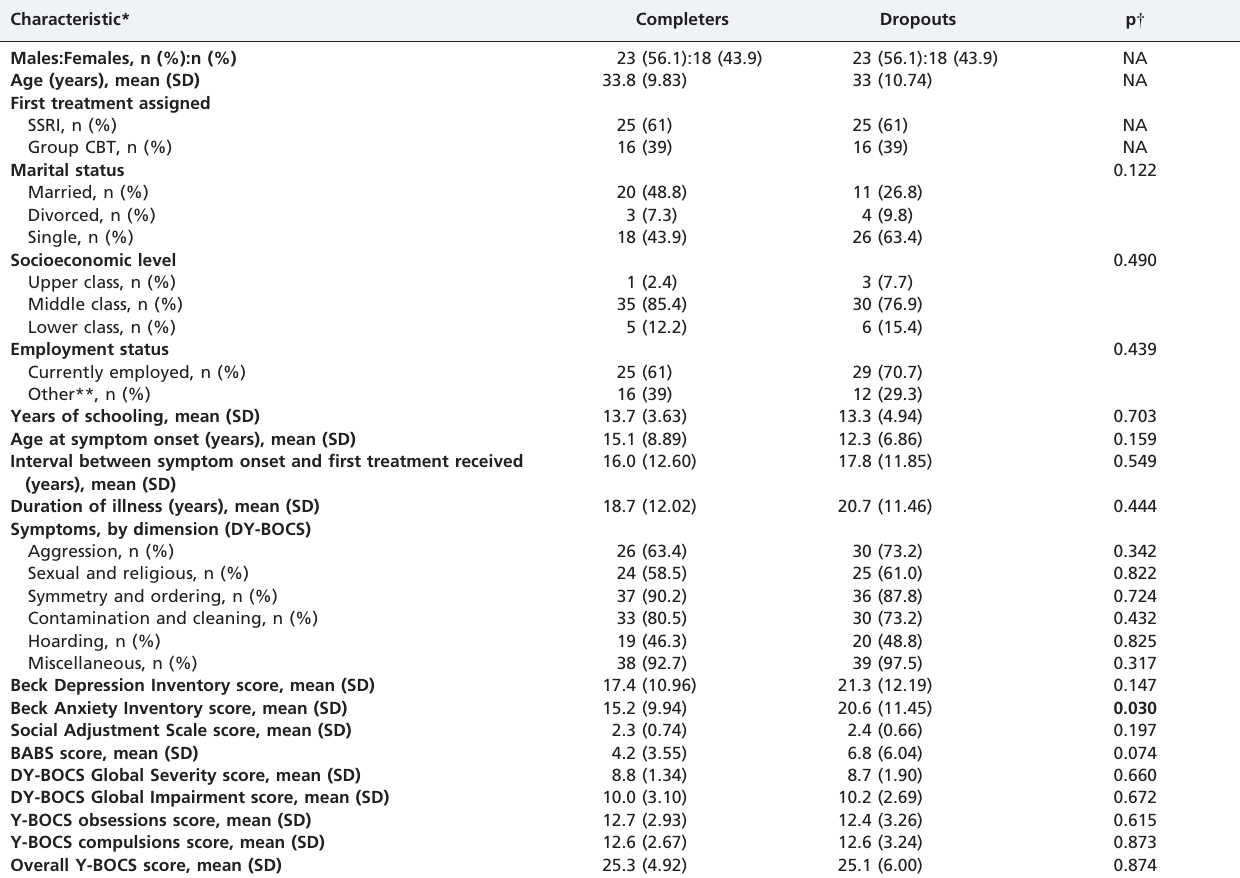
Table I - Demographic and clinical